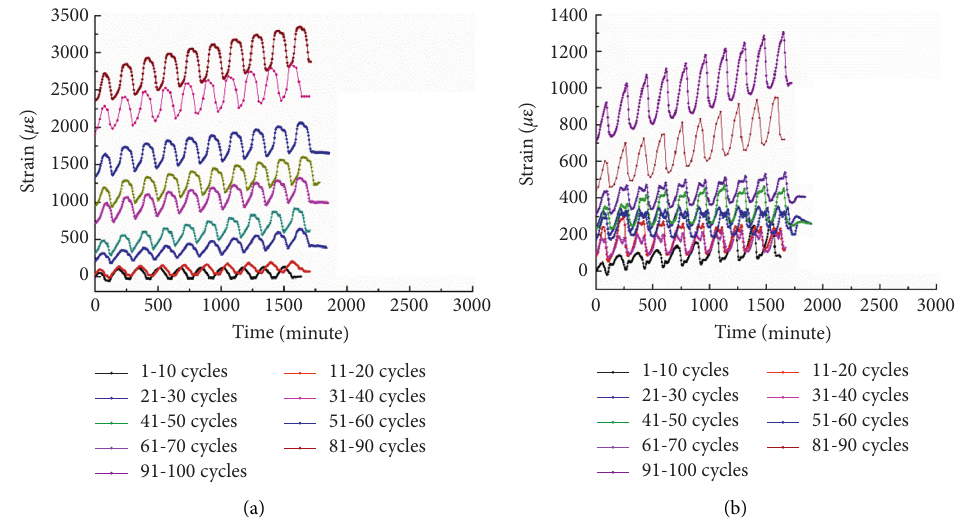
Figure 10: Strains from the start to the end of the whole F-T test. (a) W/C � 0.55. (b) W/C �